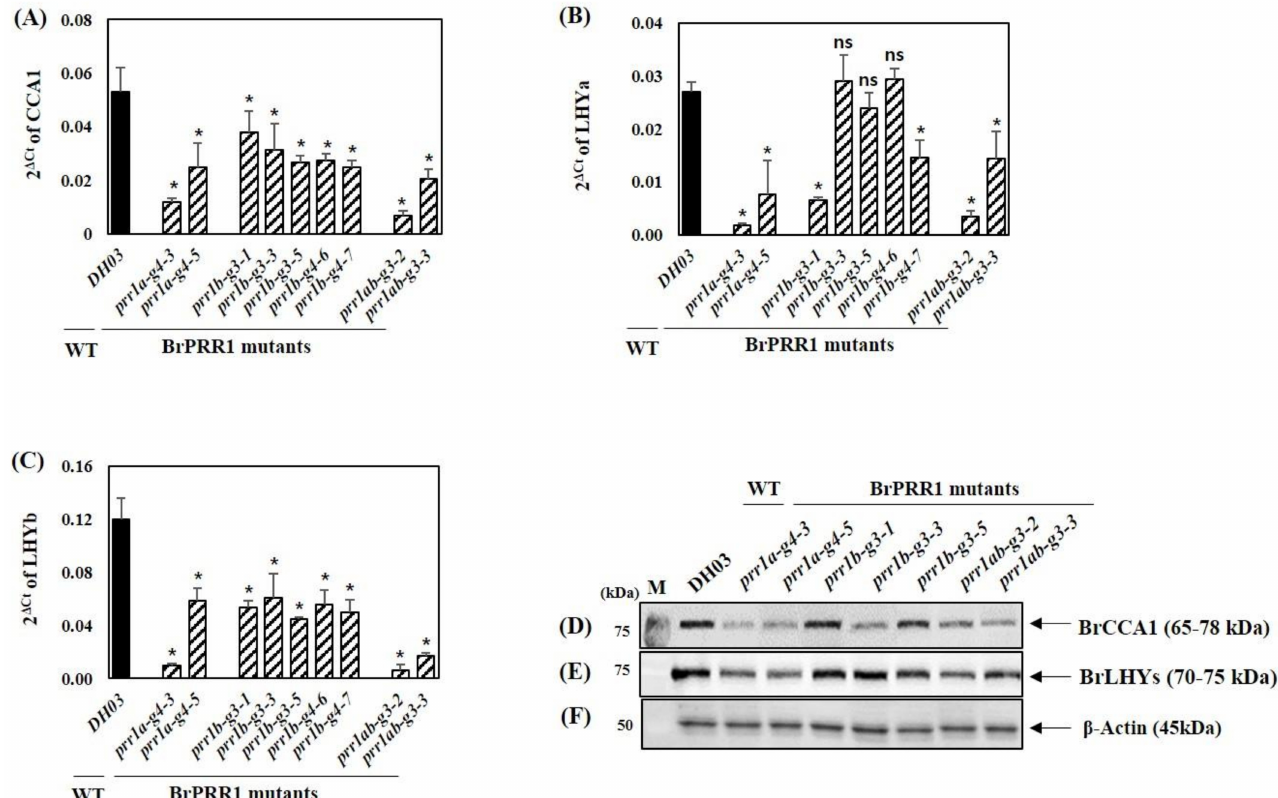
Figure 6. Expression of circadian clock gene in BrPRR1s mutants determined by qRT-PCR and Western blotting analysis. To determine the mRNA and protein expression of BrCCA1 ( A ) and BrLHYa ( B ) and b ( C ) in DH03 and BrPRR1a , 1b , and 1ab mutants of Chinese cabbage seedlings, samples were collected at ZT3 for mRNA and protein analysis with liquid nitrogen and stored at − 80 ◦ C prior to use. Western blots of 80 µ g of total protein extract from WT or BrPRR1 mutants were conducted using anti-CCA1 ( D ) or anti-LHY ( E ), or anti ß-actin polyclonal antibody ( F ) as a primary antibody and anti-rabbit HRP conjugated antibody as a secondary antibody. ß-actin was used for loading controls. Values are the means of three biological replicates, and error bars indicate standard deviation (SD). * p < 0.05 and ns = not significant compared with the wildtype control